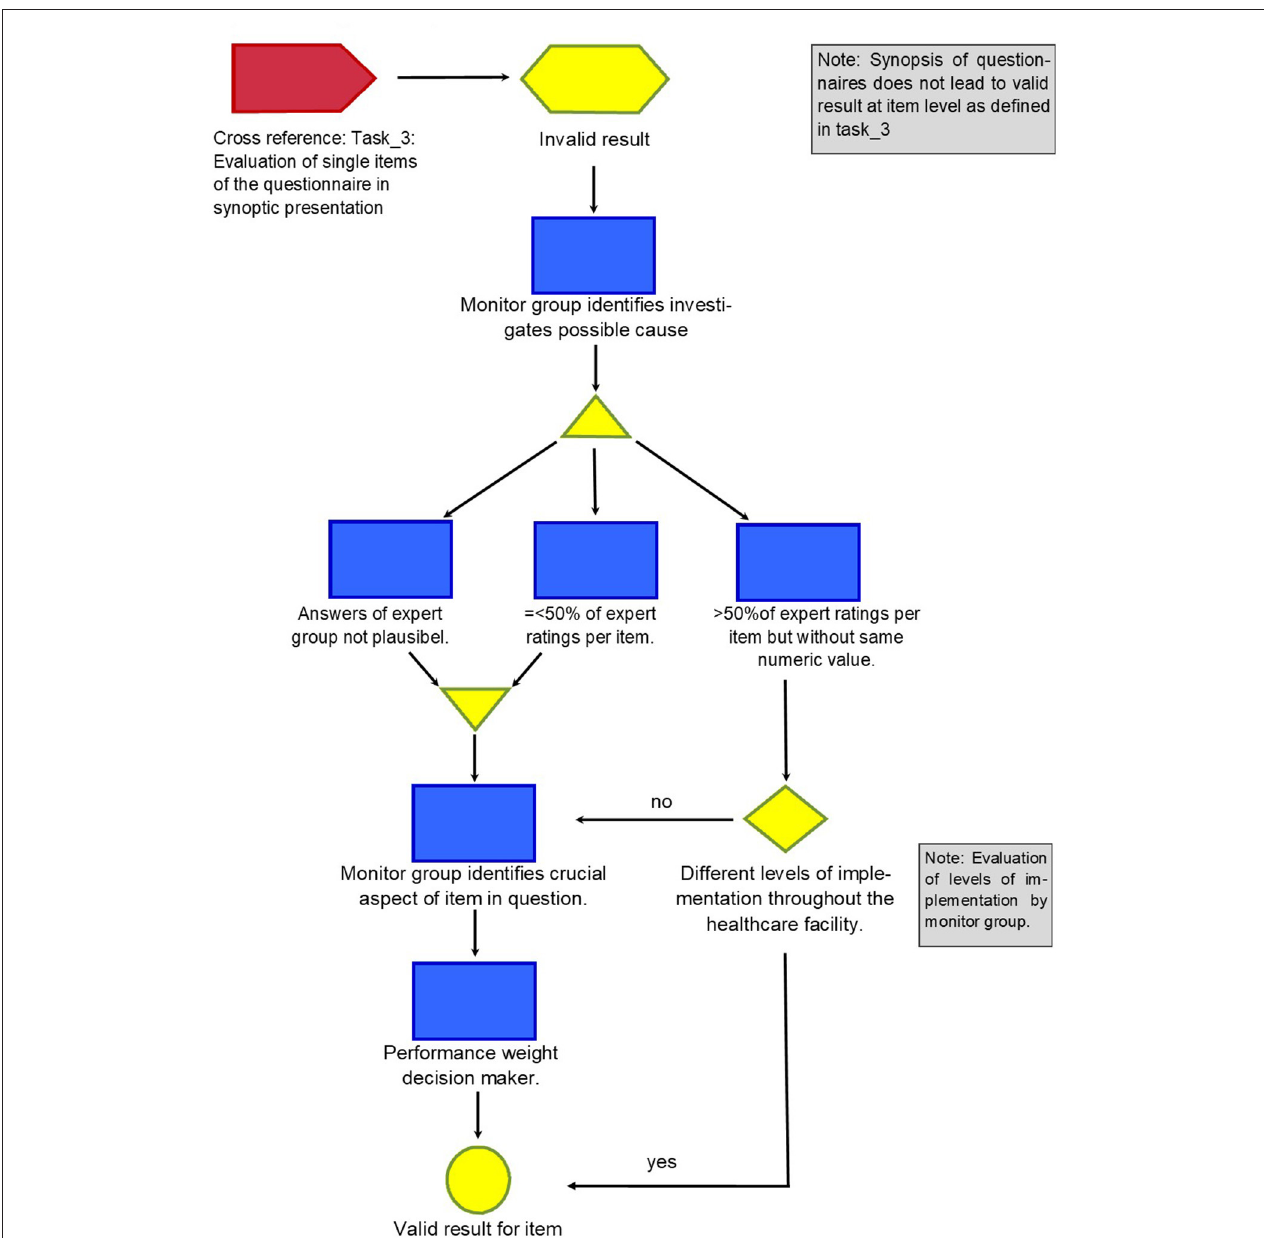
FIGURE 4 | Task_4: Consequences of an invalid